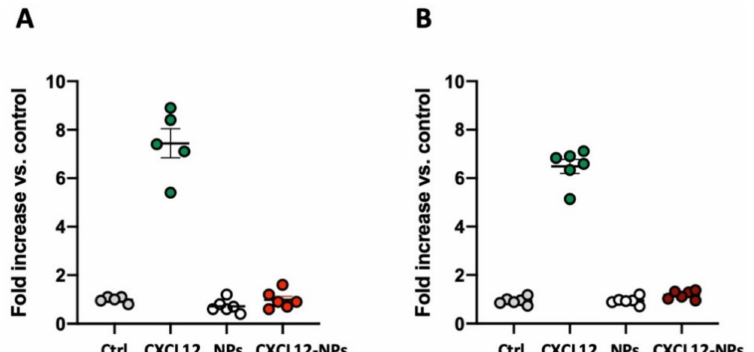
Figure 5. THP-1 cells’ migration towards non-functionalized NPs and CXCL12-NPs in both media conditions: ( A ) 10% FBS / medium; ( B ) 5% HS / medium. In total, 10 nM of CXCL12 was used as positive control. Scatter dot plots represent the fold increase of at least five independent experiments +/ − SEM, each dot representing the average of a triplicate.